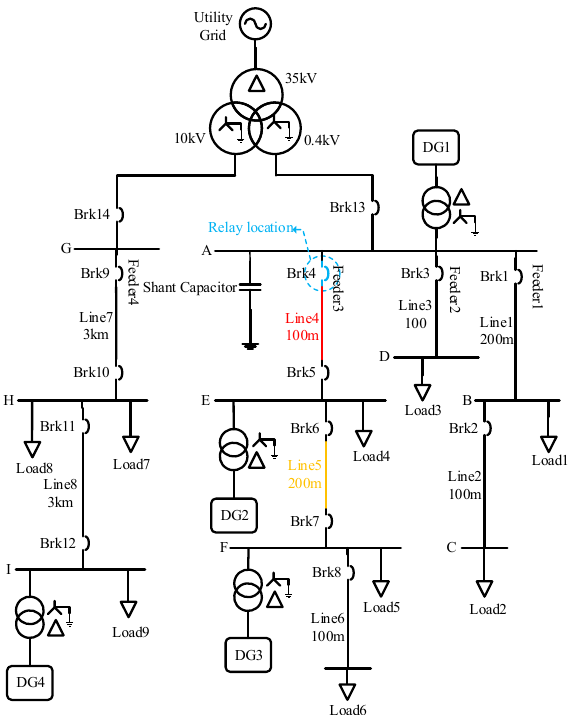
Figure 14. Case study system.